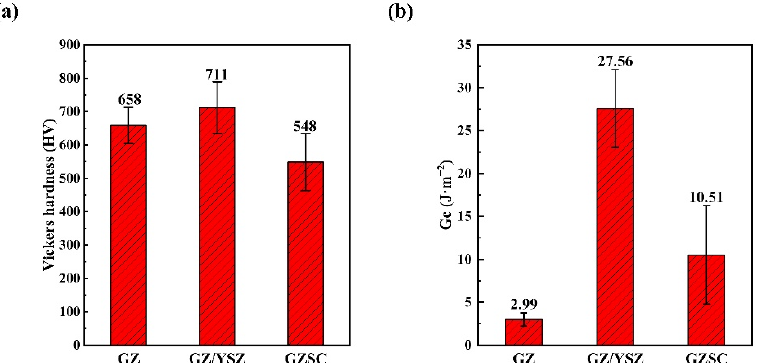
Figure 5. Mechanical properties of the as-sprayed coatings: ( a ) Vickers hardness and ( b ) fracture toughness.